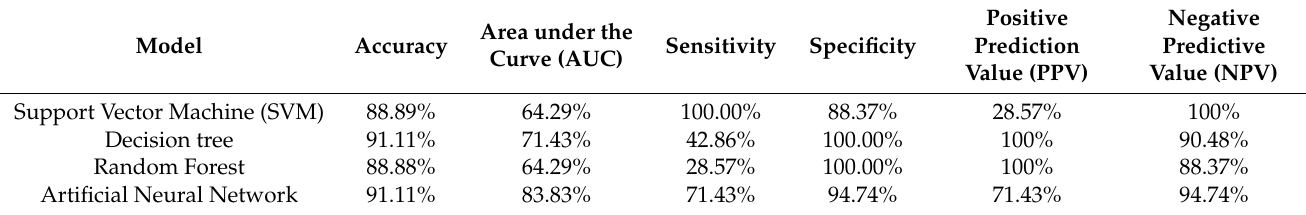
Table 4. Accuracy, area under the curve (AUC), sensitivity, specificity, positive prediction value (PPV), and negative predictive value (NPV) of support Vector Machine (SVM), decision tree, random forest, and artificial neural network for COVID-19 detection and